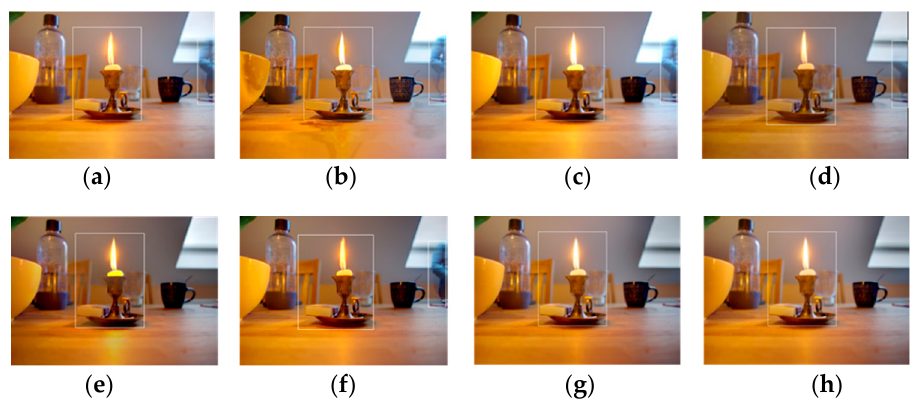
Figure 8. Results of different methods on the image sequence “Candle”. ( a ) Mertens et al. [12]. ( b ) Shen et al. [18]. ( c ) DE-MEF [20]. ( d ) Photomatix [36]. ( e ) Hayat et al. [21]. ( f ) Huang et al. [22]. ( g ) MBLBP-1. ( h ) MBLBP-2.